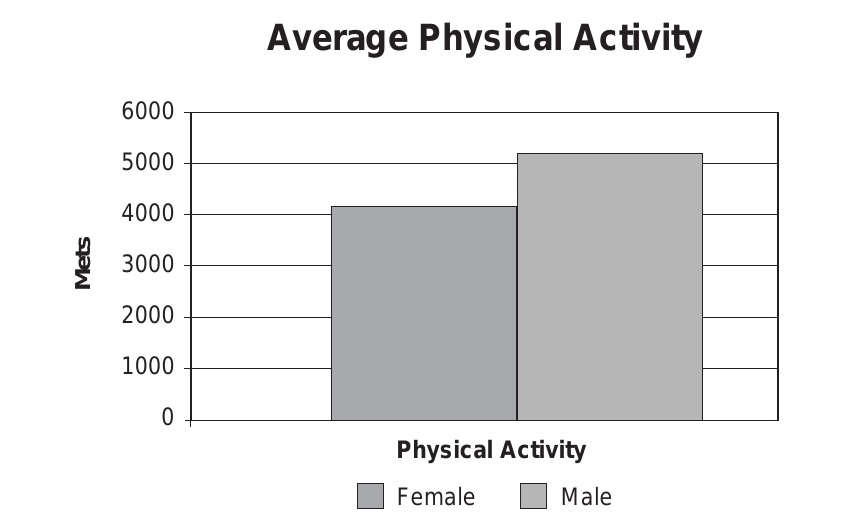
Figure 2: Difference between male and female’s average physical activity measured in